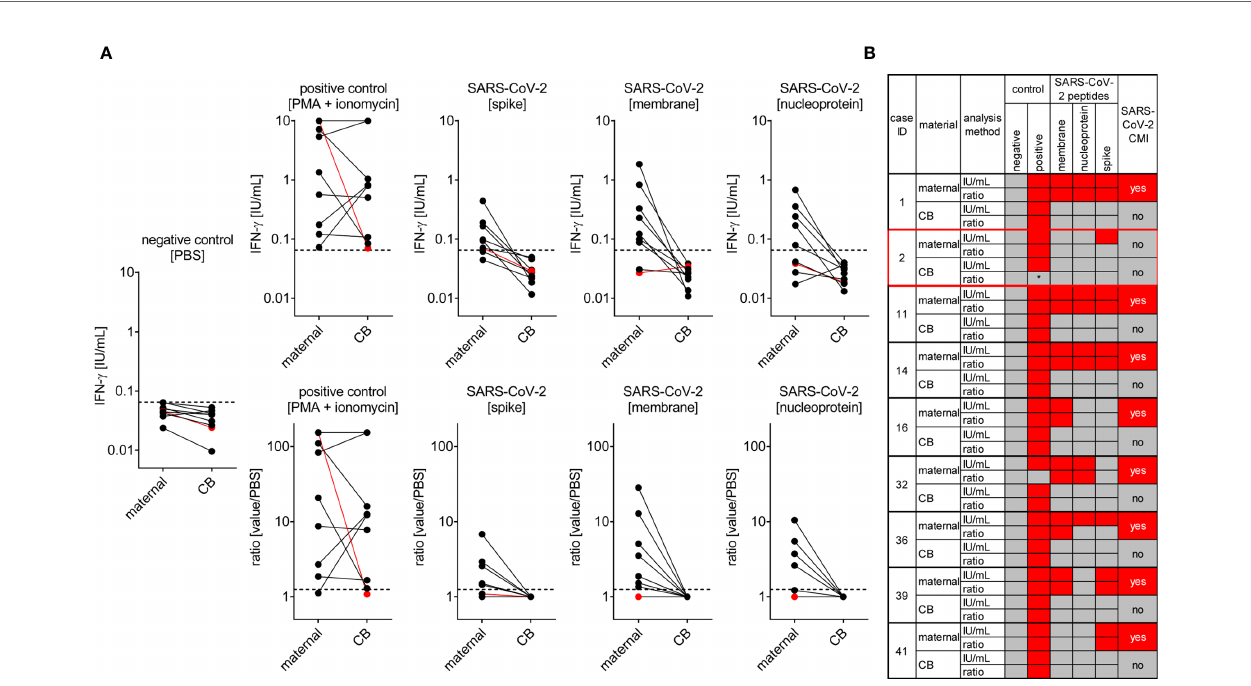
FIGURE 4 | SARS-CoV-2 cell-mediated immunity (CMI) in mother and neonate. Maternal and cord (CB) blood samples of six mother-baby pairs were analyzed for SARS-CoV-2-speci fi c CMI applying an IFN- g release assay. Blood samples were treated with stimulants as indicated and IFN- ɣ was measured in supernatants. (A) Absolute measurements (upper row) and calculated ratios to the negative control (lower row) are depicted as indicated. Red dots refer to the mother-baby pair from case #3, where CMI was tested two days after a positive viral RNA swab. (B) Cumulative data interpretation of all measurements applying criteria as outlined in the Material and Methods section. *, this individual ’ s positive control was negative after stimulation with PMA + ionomycin but positive after stimulation with SEB. Clinical details of the participants are listed in Supplementary Table 1 , please see the case IDs on left to idenitfy the cases in the